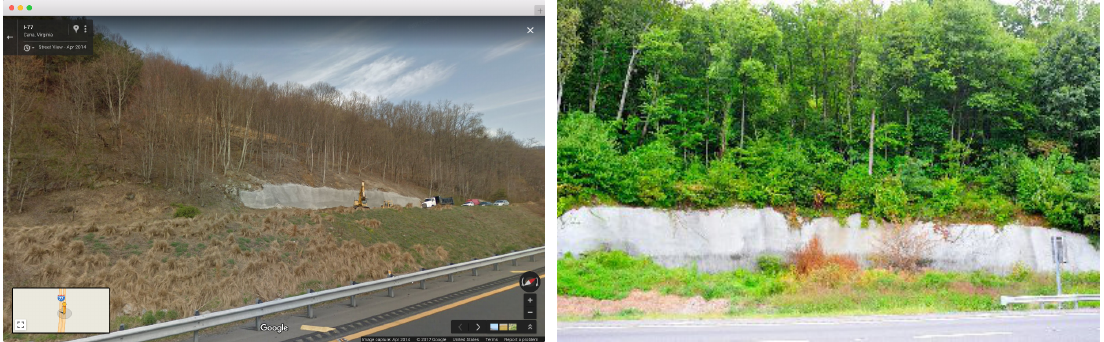
Figure 17. The location and photo of the soil slope and the retaining wall at MP1.8 of